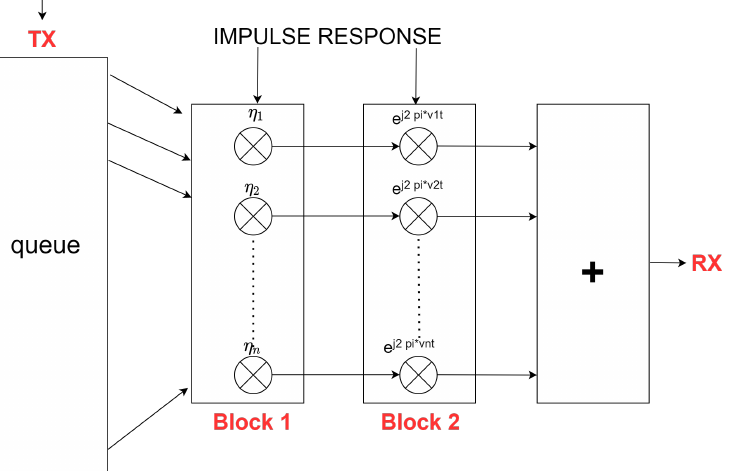
Figure 4. Channel emulation model. Modifying the I&Q signal by shifting the phase and amplitude of each